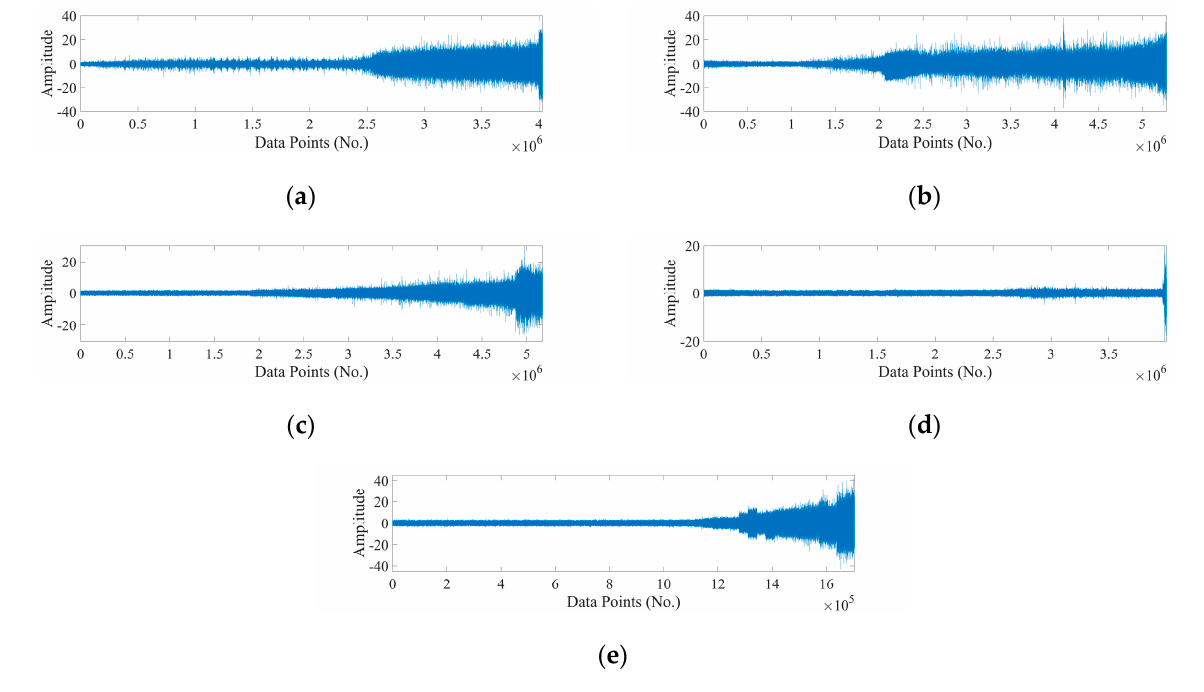
Figure 4. Raw vibration signals used in this paper. ( a ) Bearing 1_1, ( b ) Bearing 1_2, ( c ) Bearing 1_3, ( d ) Bearing 1_4, ( e ) Bearing 1_5.